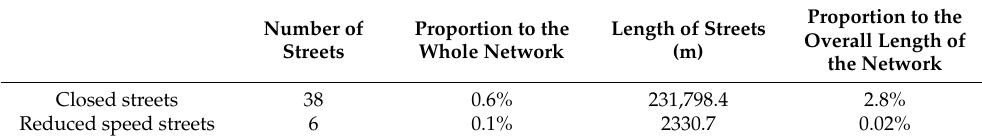
Table 3. Number and length of flooded or reduced speed streets. Deep flooding (over 0.3 m)